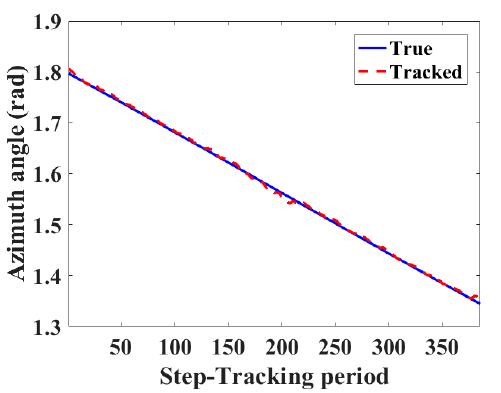
Figure 9. Azimuth tracking results of the plane model.